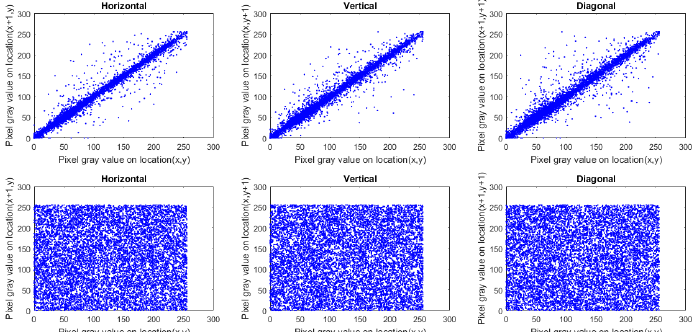
Figure 13. Plots of correlation distribution (in each direction) for Macaws image (Blue channel), in which the first row denotes the plain Macaws image, while the bottom row signifies the ciphered Macaws image.